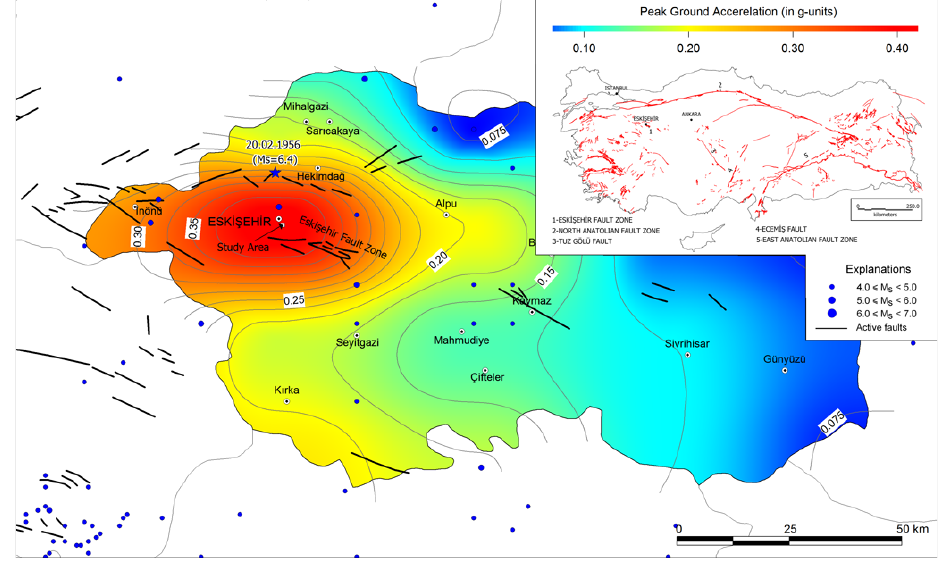
Fig. 4. Peak ground acceleration map, with main fault systems and major earthquakes greater than 4 for Eskis¸ehir City (modified from Orhan et al., 2007).